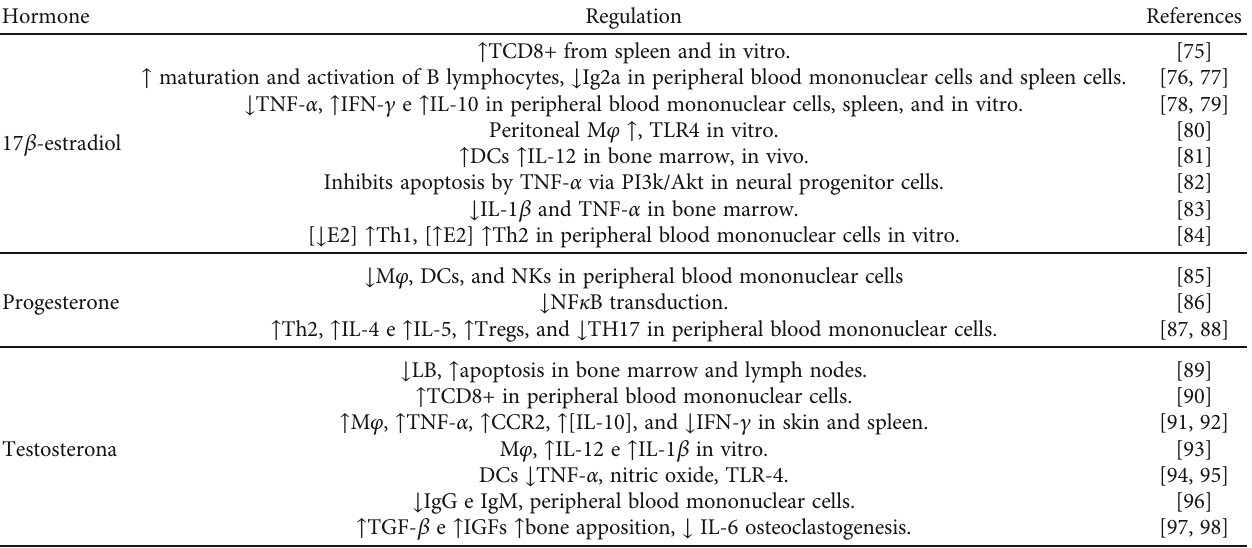
Table 1: In fl uence of sex hormones on some cells and cytokines of the immune